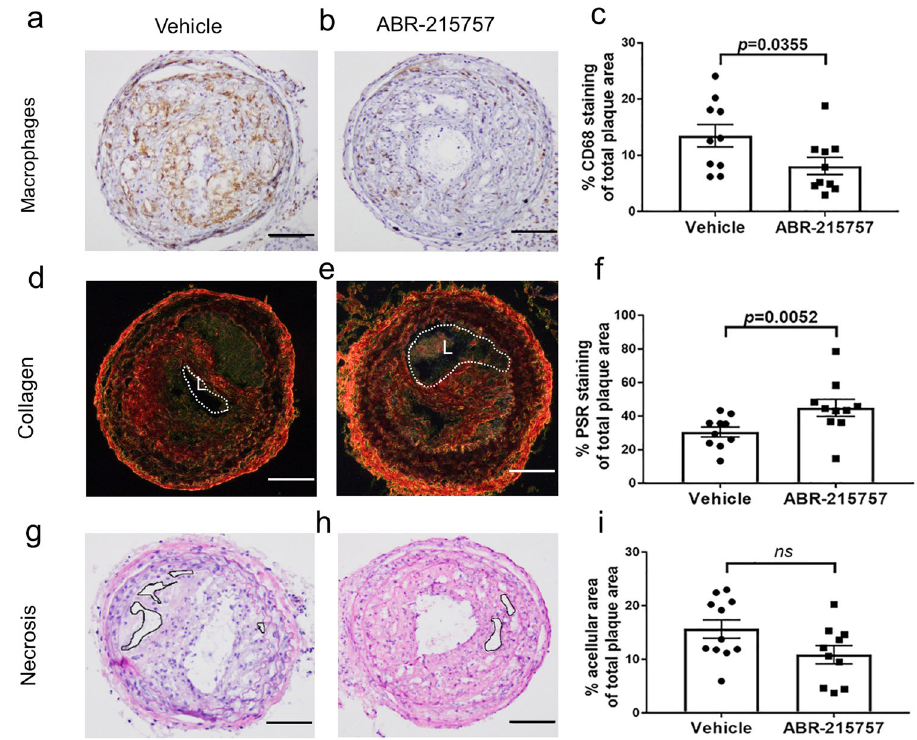
Fig. 5 Inhibition of S100A9 stabilizes vulnerable atherosclerotic plaques in the TS mouse model. ApoE − / − mice were given ABR-215757 (S100A9 inhibitor, 25 mg/kg, intraperitoneal injection) three times weekly for 7 weeks after TS surgery. a , b In mice treated with ABR-215757, TS mouse plaques showed a considerable reduction in CD68 foam cells. c CD68 quanti fi cation in percent of the atherosclerotic area. d , e Plaque collagen was detected with Picro Sirius red staining under polarized light, and f treatment with the inhibitor dramatically increased plaque collagen content. g , h H/E staining was utilized to de fi ne the necrotic core relative to the total plaque area. i Treatment with the S100A9 inhibitor showed a trend of lowering the necrotic core size. Data are presented as means and standard error of the mean (S.E.M.). The total plaque area refers to the plaque from the internal elastic lamina to the endothelium. Each dot represents the mean value of six sections from one mouse. L: Lumen. Student ’ s t-test was used to test for statistical signi fi cance. Bars represent 50 μ